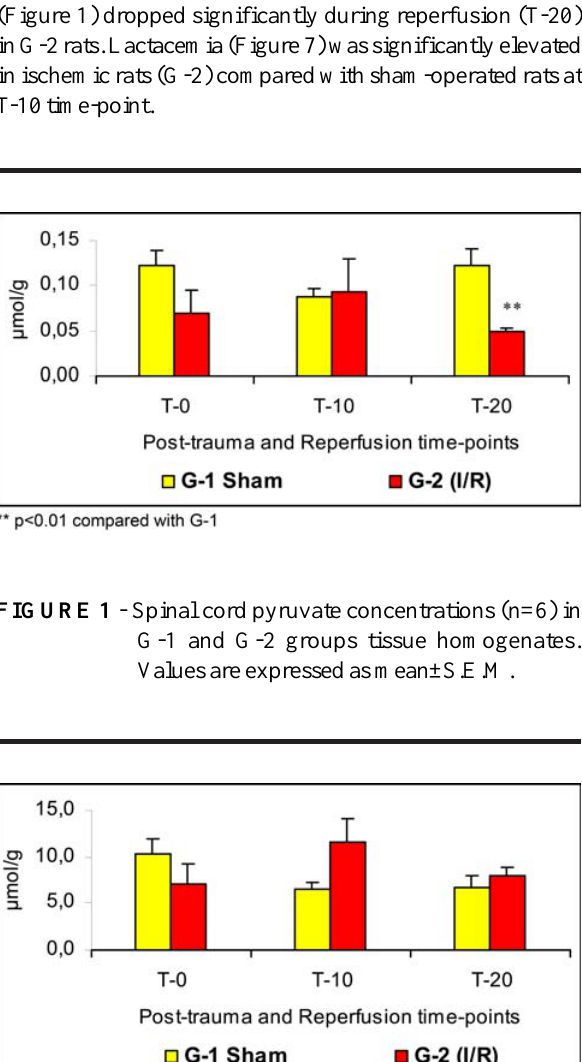
FIGURE 2 - Spinal cord lactate concentrations (n=6) in G-1 and G-2 groups tissue homogenates. Values are expressed as mean±S.E.M.